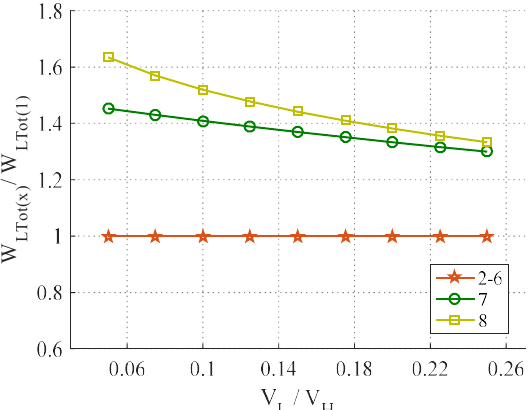
Figure 7. Total energy stored in inductors, as a function of the voltage conversion ratio (converters 1–8 described in Table 1).